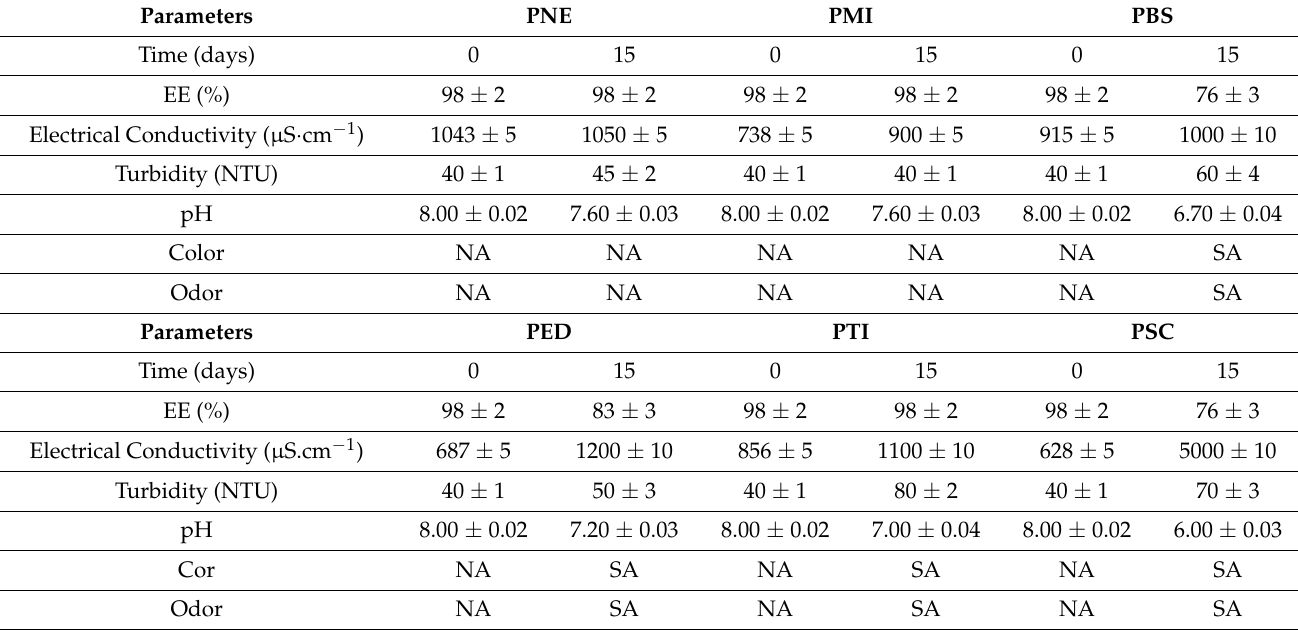
Table 2. Preliminary stability parameters obtained at (35 ± 2) ◦ C for loaded particles containing